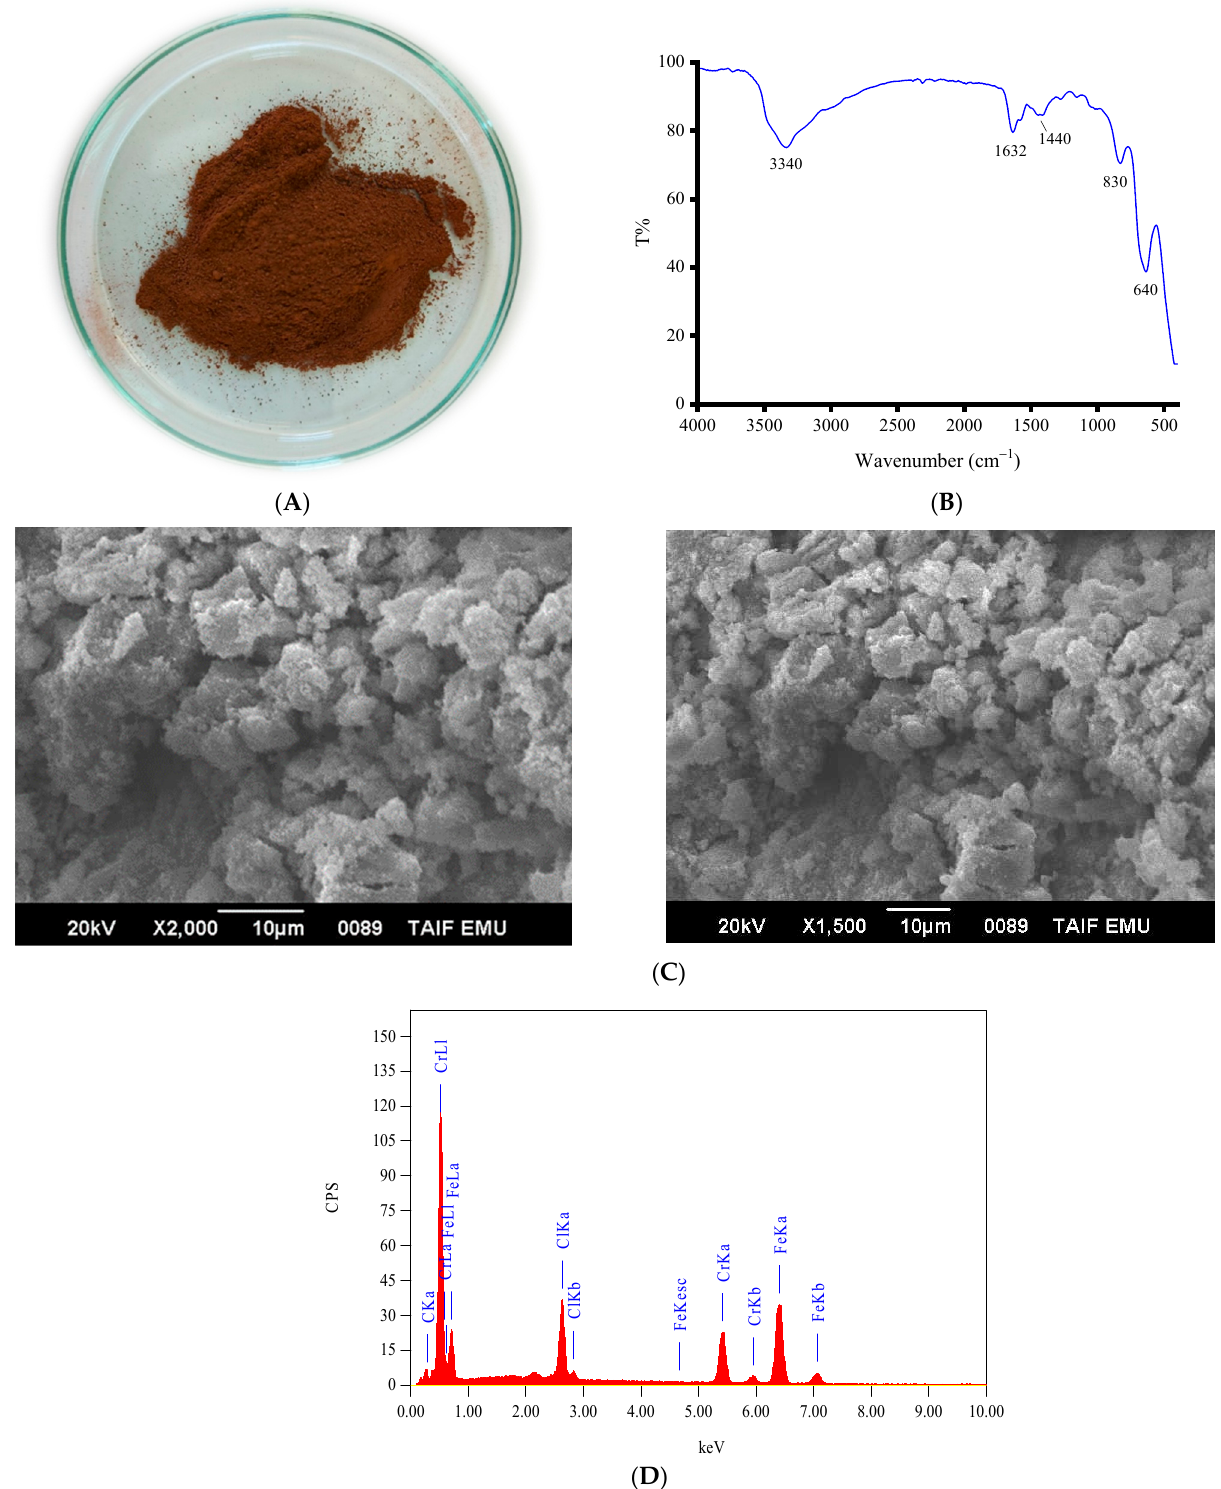
Figure 1. Characterizations of the solid product generated from the reaction of urea with CrCl 3 and FeCl 3 : ( A ); Color and shape of the product, ( B ); IR spectrum, ( C ); SEM image, and ( D ); EDX